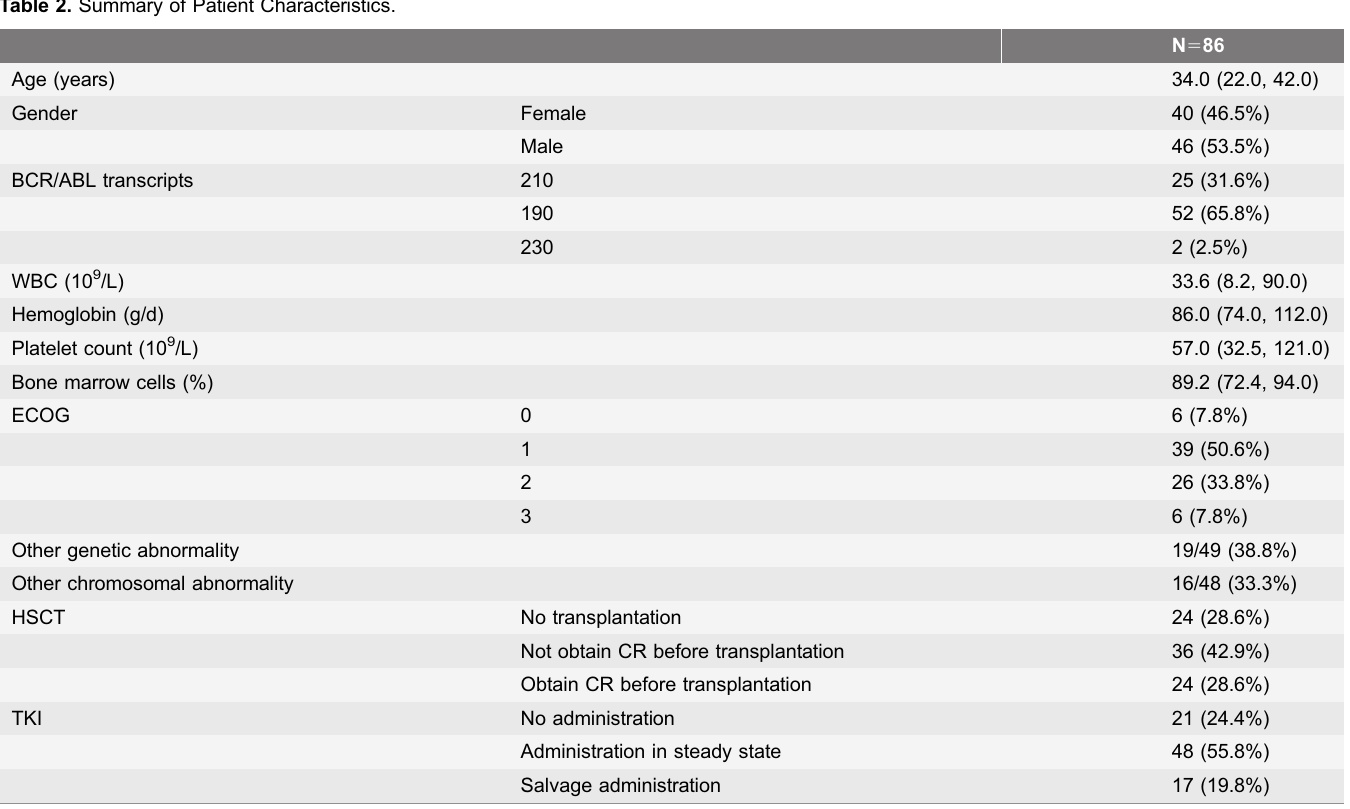
Table 2. Summary of Patient